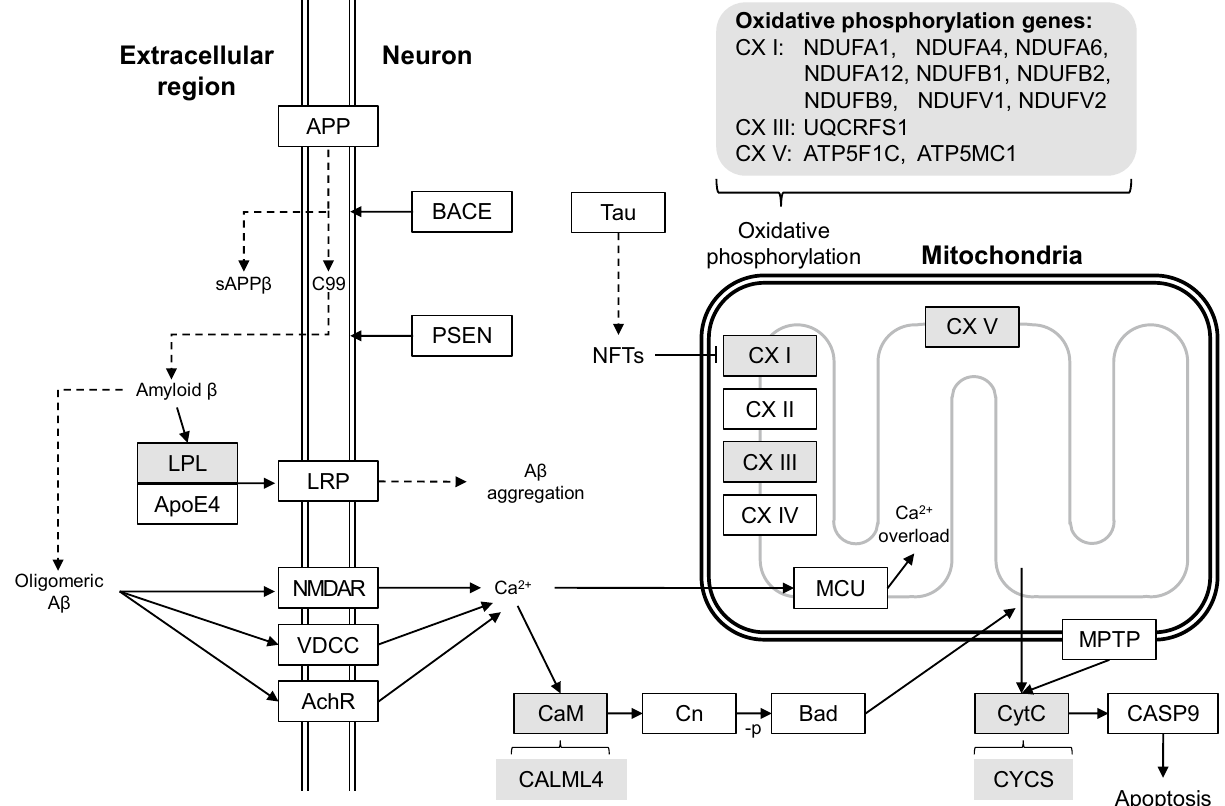
Figure 4. The ML-identified genes enrich the KEGG AD pathway. Proteins or protein complexes are shown in squares. Only a part of the KEGG AD pathway is shown. Dash line arrows indicate transformation, while solid line arrows indicate a reaction. The enriched proteins or protein complexes are drawn in grey, with the ML-identified genes noted at the open bracket near